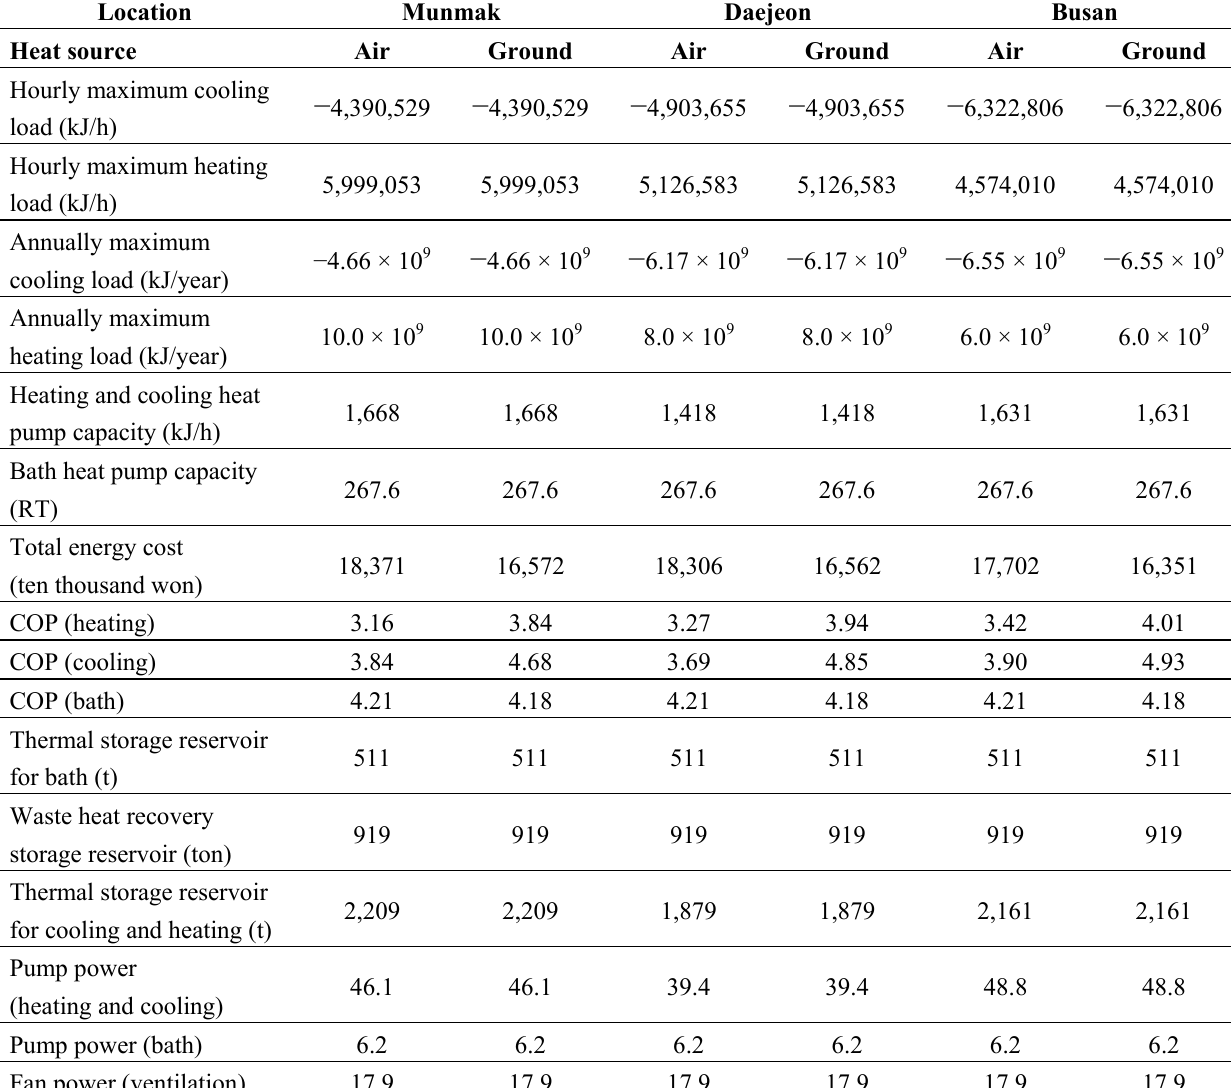
Table 4. Heat pump system simulation results for heating and cooling a resort building (total floor area 33,000 m 2 , Heat recovery, Night-electricity driven heat pump system).